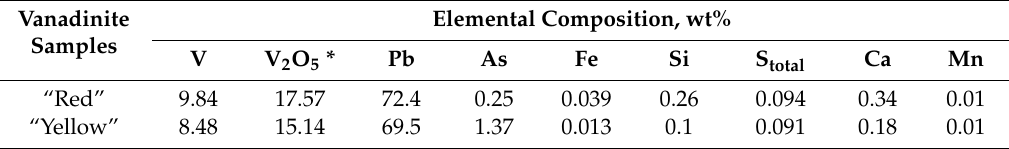
Table 4. The chemical analysis of red and yellow vanadinite samples.